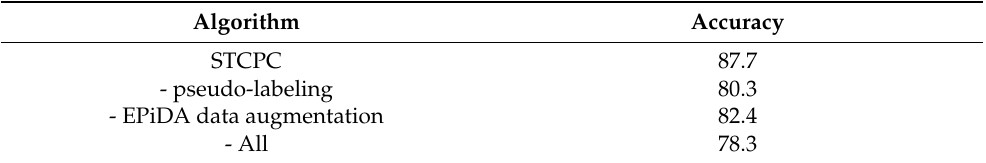
data augmentation